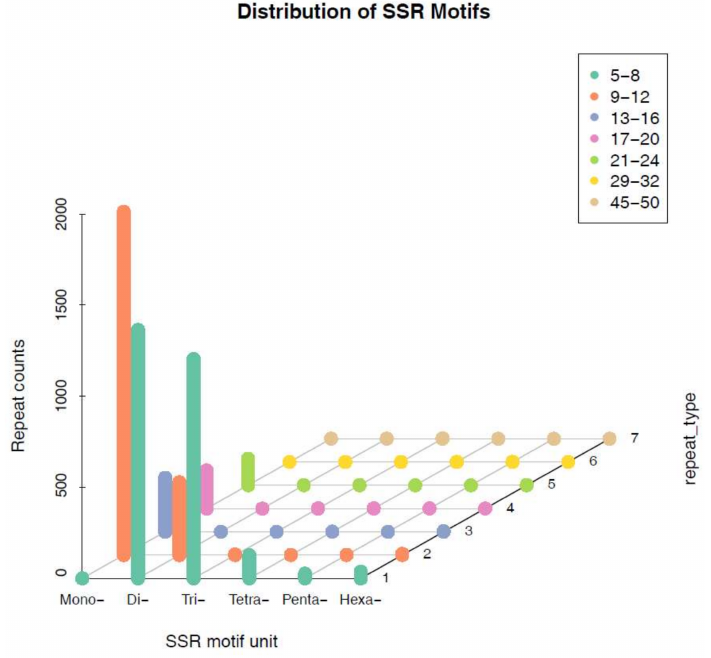
Figure 1. The distribution of SSR motif and repeat